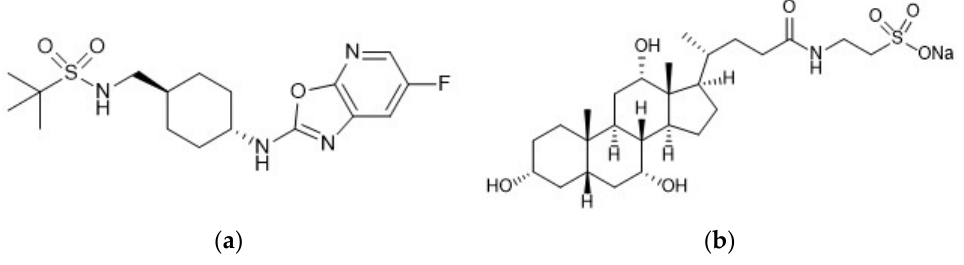
Figure 1. Chemical structures of ( a ) AntiY 5 R and ( b ) NaTC. The TG/DTA profile of AntiY 5 R indicated that the Tm and thermal degradation of AntiY 5 R were 250.2 ± 0.2 °C and over 300.5 ± 1.1 °C, respectively (Table 1 and Figure 2a),